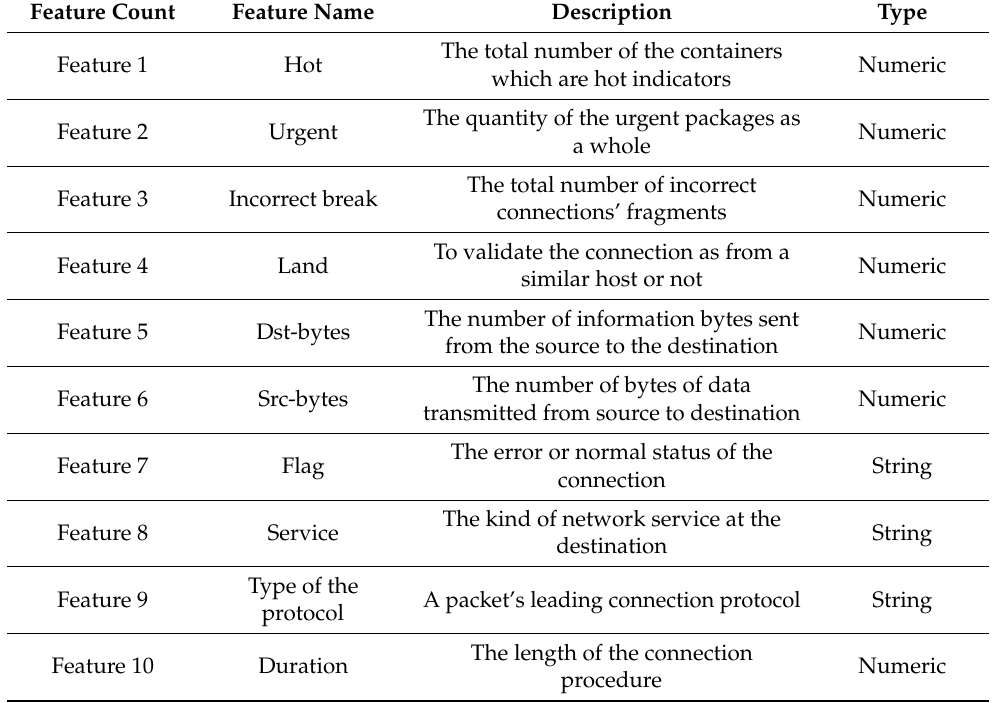
Table 1. Characteristics of the